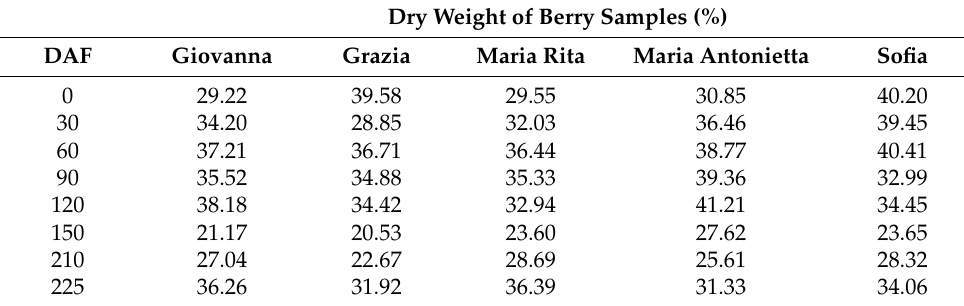
Table 4. Dry weight expressed in percentage of myrtle berry